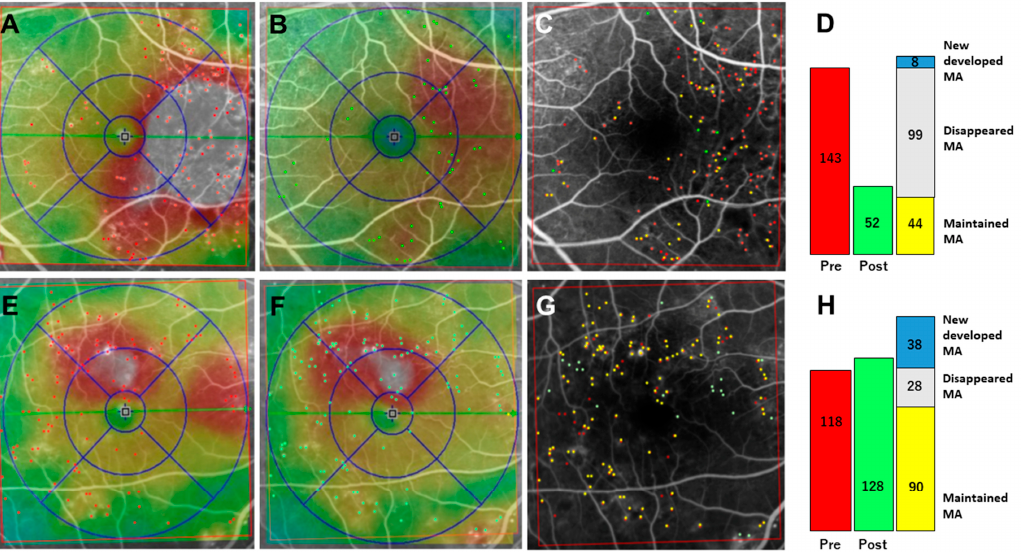
Figure 3. A sample case showing microaneurysm turnover after faricimab treatment. Fluorescein angiography (FA) image was merged with OCT map in the eye treated with faricimab ( A – C ). MAs before ( A ) and after ( B ) faricimab treatment and were filled in red and green, respectively, and these figures were merged ( C ). Images taken at same time point in another untreated eye were shown in ( E – G ). Color bar indicates the number of MAs before (red), after (green), new developed (blue), disappeared (gray), and maintained (yellow) in the eyes treated ( D ) and untreated ( H ) with faricimab.